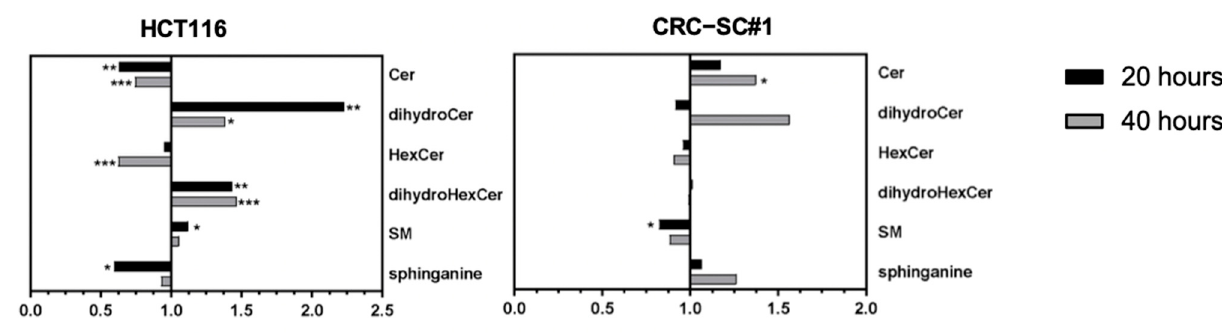
Figure 11. Analysis of sphingolipids for HCT116 and CRC-SC#1 cell lines. Graphs displaying fold change for HCT116 cells ( left panel ) and CRC-SC#1 cells ( right panel ) relative to ceramides (Cer), hexosylceramides (HexCer), sphingomyelins (SM), sphinganine, dihydroCer, and dihydroHexCer species merging 20 and 40 h treatment. *: Student’s t -test p < 0.1; **: Student’s t -test p < 0.01; ***: Student’s t -test p < 0.001.